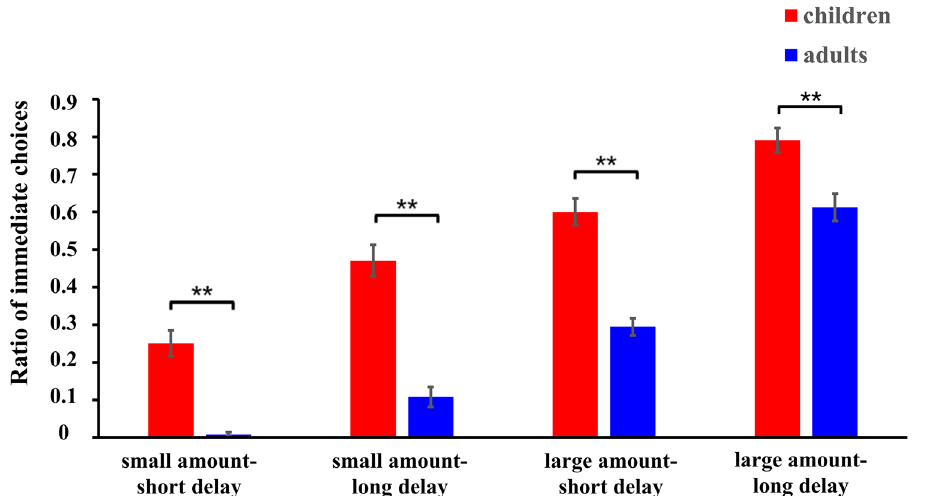
Figure 2. The mean percentage for immediate reward choices during the four conditions in children and adults. The picture was created by Microsoft Excel 2016 MSO (16.0.13628.20234) 64 bits (https:// www. micro soft. com/ zh- cn/ micro soft- 365/ excel) and Microsoft PowerPoint 2016 MSO (16.0.13628.20234) 64 bits (https:// www. micro soft. com/ zh- cn/ micro soft- 365/ power